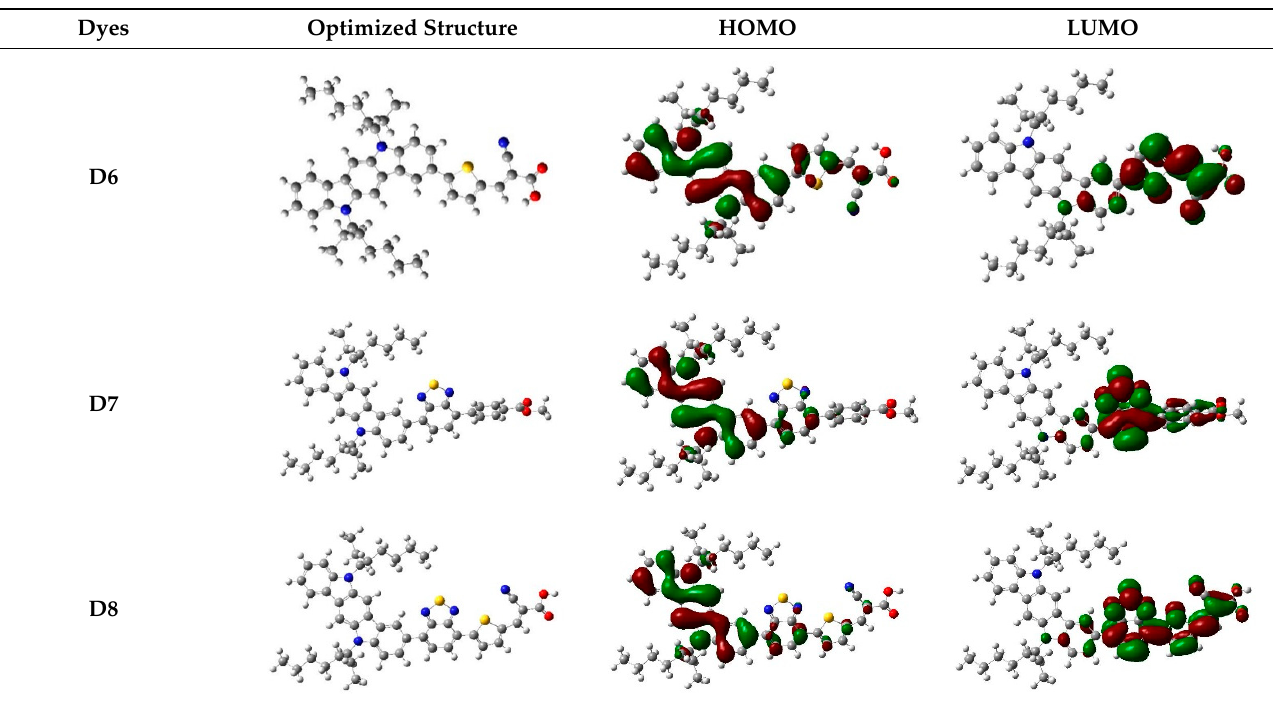
Table 2. Optimized molecular geometries and electron distributions of the dyes.